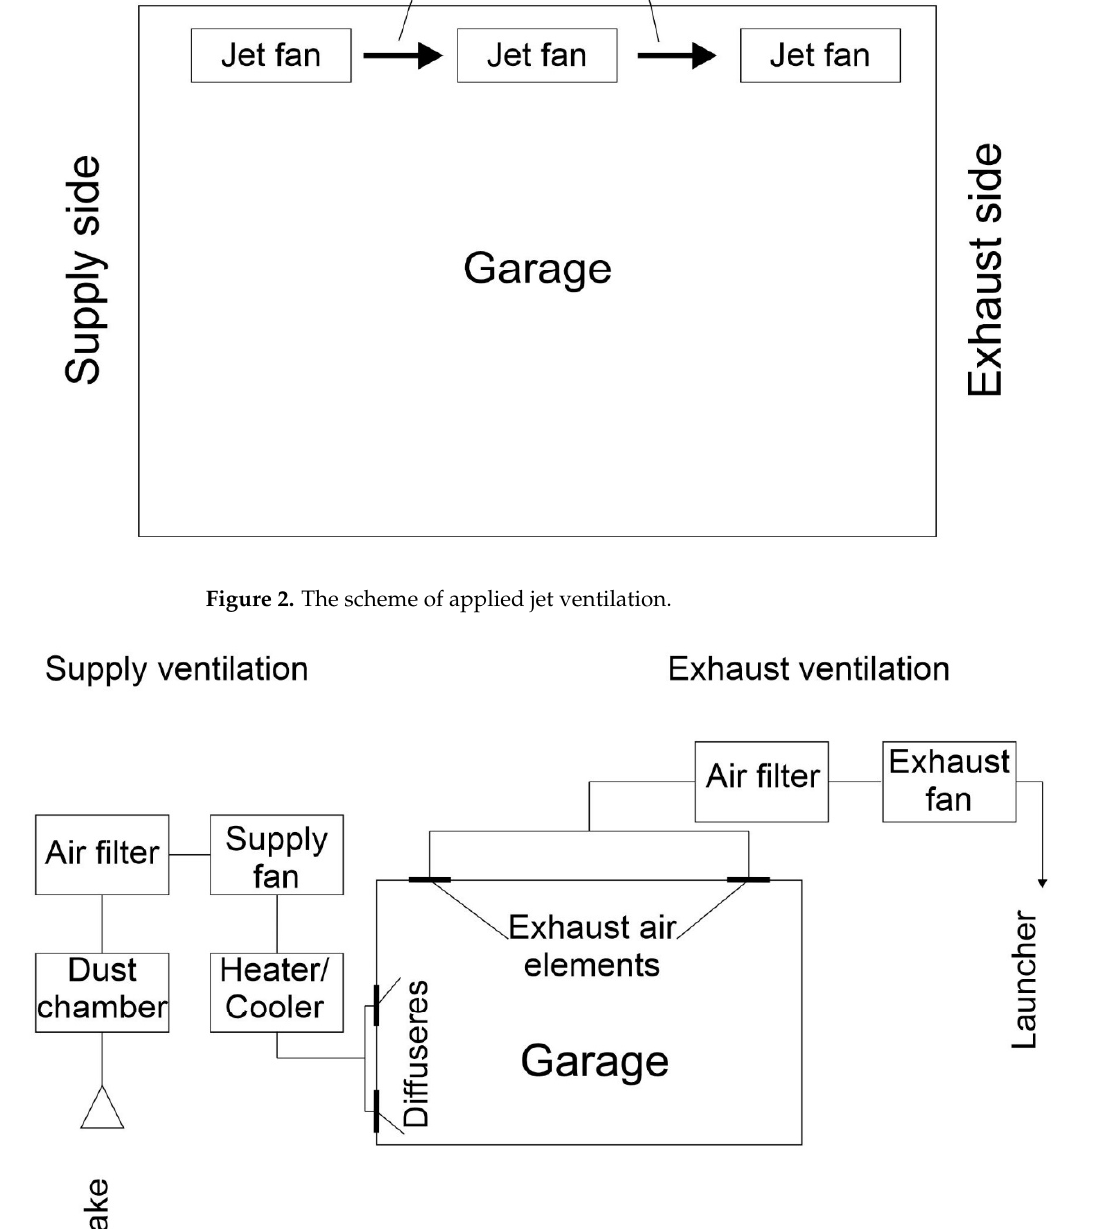
Figure 3. The scheme of applied duct